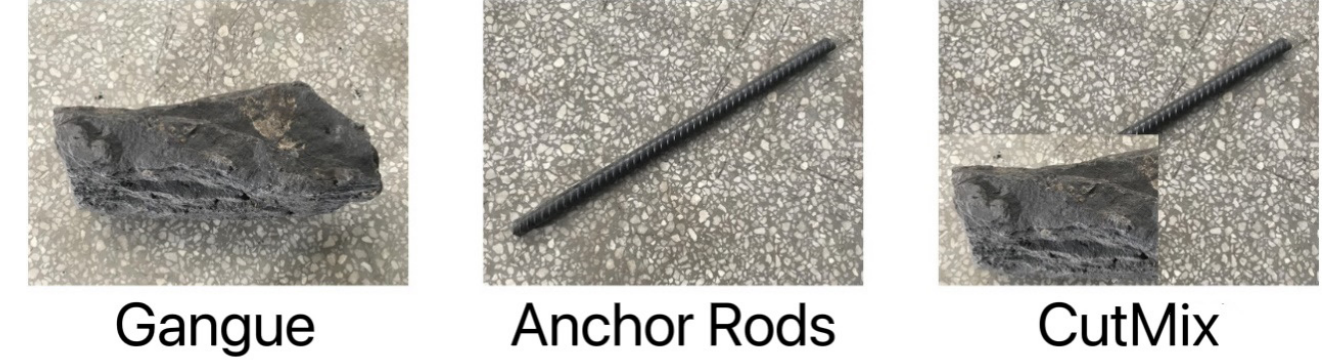
Figure 4. CutMix pictures.